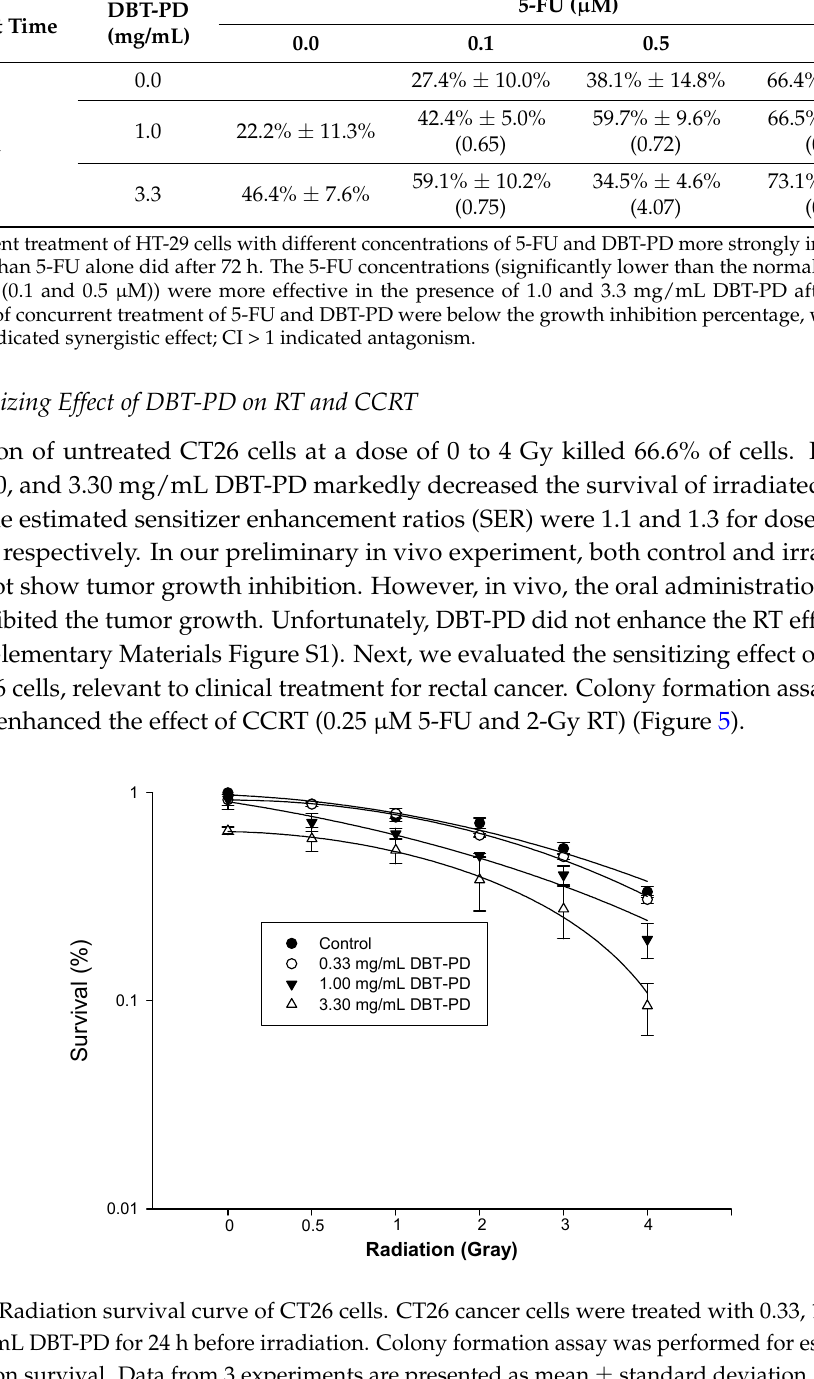
Figure 5. Effect of DBT-PD on survival of CT26 cells subjected to CCRT. CT26 cancer cells were treated with 0.25 µM 5-FU and 1.0 or 3.3 mg/mL DBT-PD for 24 h before 2-Gy irradiation. A colony formation assay was performed to estimate survival post CCRT. Data from 3 experiments are presented as mean ± standard deviation. 3. Discussion DBT, an ancient Chinese herbal formula for menstrual anemia, was shown to inhibit the growth of and enhance efficacy of RT, 5-FU, and CCRT in CT26 cells. In clinical practice, TCM physicians frequently use DBT to manage general deficiencies of qi and blood. For patients receiving anti-cancer treatments, DBT is prescribed to reduce fatigue and promote recovery from adverse effects related to anti-cancer treatments. However, ambiguities exist that raise concerns about interactions among DBT, cancer cells, and anti-cancer treatments. While the beneficial effects of DBT have been reported in some cancer cells [12,14,17], TCM physicians have been considering the possible benefits of incorporating this ancient formula into modern anti-cancer treatment modalities. In this study, we used colorectal